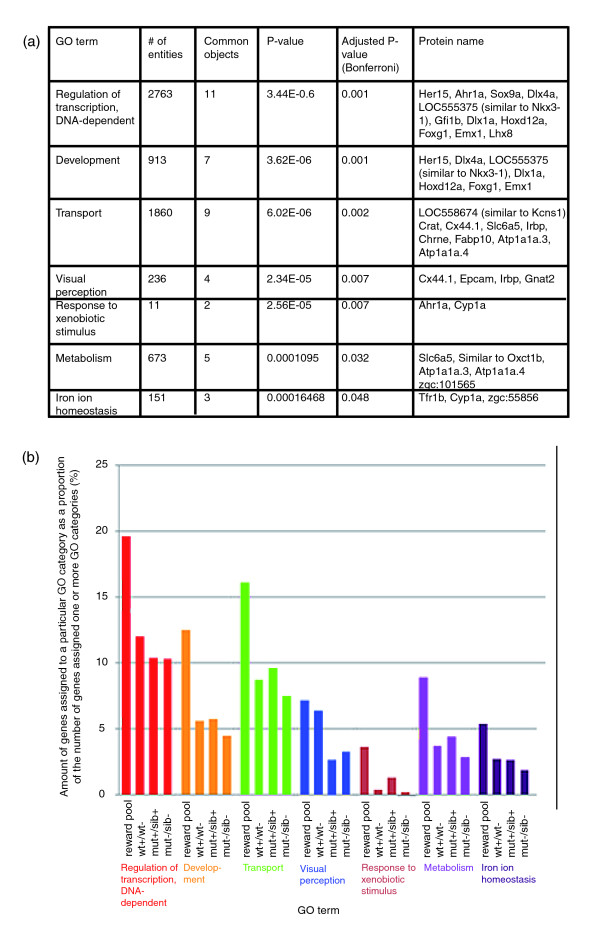
Categorization of the 139 genes contained in the reward pool. (a) Gene Ontology (GO) term enrichment analysis for terms included in the category 'biological process'. Terms were considered to be significantly enriched if the adjusted P-value was < 0.05. Redundant terms have been excluded. (b) Bar graph comparing the amount of genes assigned to a particular category as a percentage of all genes that could be assigned one or more GO terms. The depicted categories were chosen from the analysis in (a). For the experiment wt+/wt- 517 genes were assigned a GO term, for mut+/sib+ 386, for mut-/sib- 493 and for the reward pool 56.